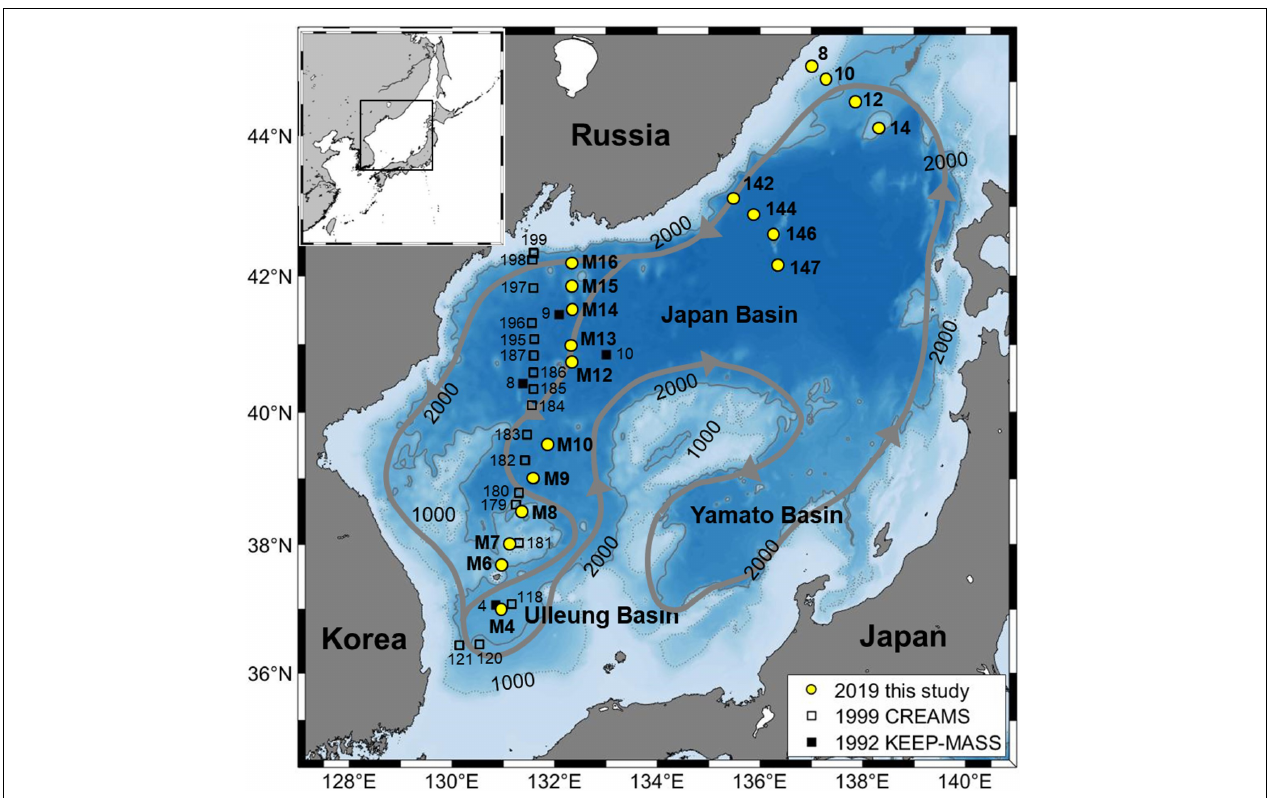
FIGURE 1 | Bathymetric map of the East Sea (Japan Sea) showing study sites in 2019 (circles). Open squares and black squares respectively represent stations of the Circulation Research of East Asian Marginal Seas project in 1999 (Talley et al., 2004) and the Kuroshio Edge Exchange Processes-Marginal Seas Studies in 1992 (Chen et al., 1995). The conceptual abyssal circulation suggested by Senjyu et al. (2005) is also shown.